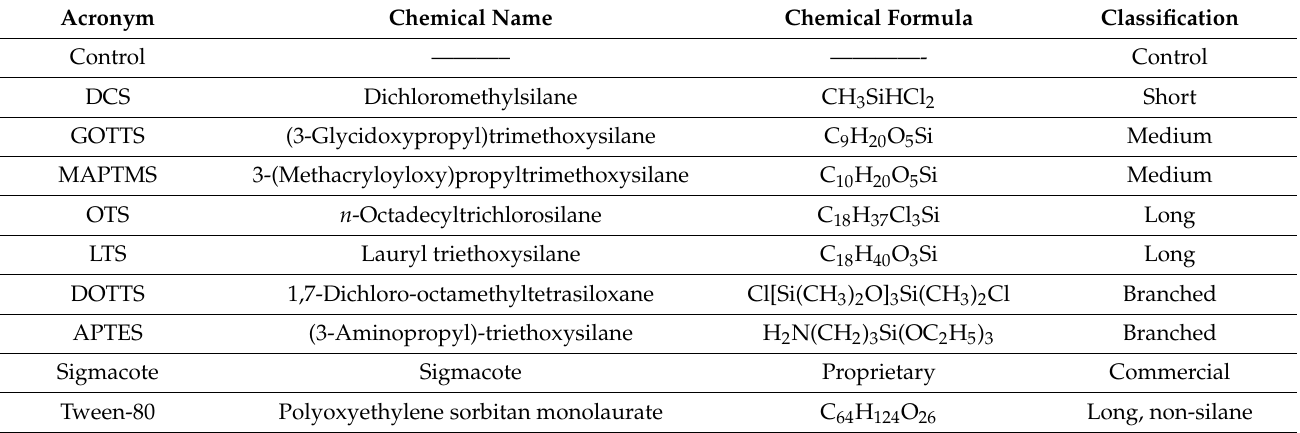
Figure 1. Schematic of different surfactant coatings on the inside glass surface of a valved NMR tube. Red ‘x’ denotes paramagnetic impurity within glass surface. Blue dots represent pH 2 molecules in the gas phase. Black chemical structures are different surfactants: ( a ) bare glass, ( b ) DCS, ( c ) GOTTS, ( d ) OTS, and ( e ) DOTTS. See Table 1 for full names and chemical formulas. Table 1. Chemical information regarding the surfactant molecules used in this study. Vendor information available in the Supplemental Materials Table S1.